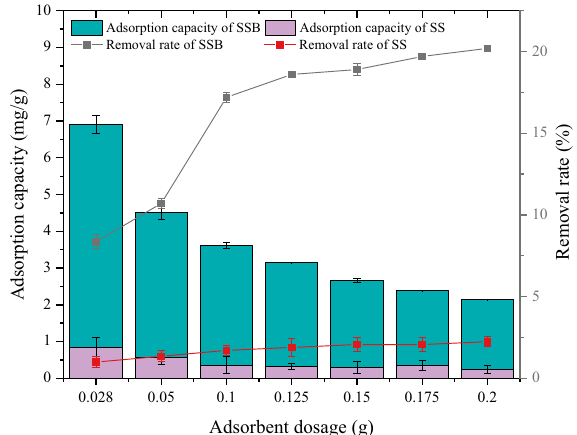
Figure 4. The effect of dosage on ammonium adsorption.